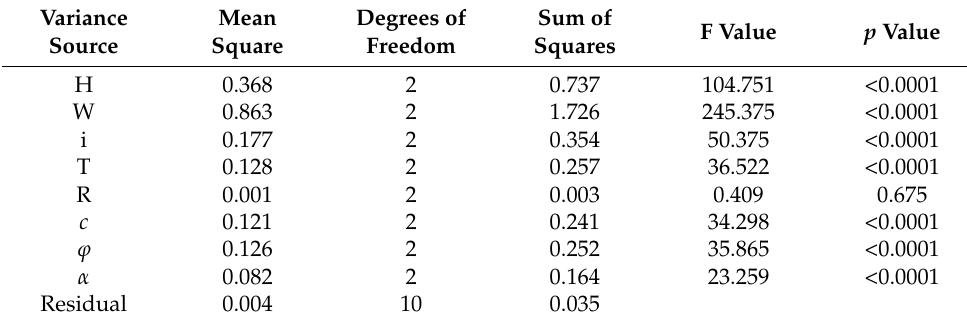
Table 12. Variance analysis of the factors affecting slope